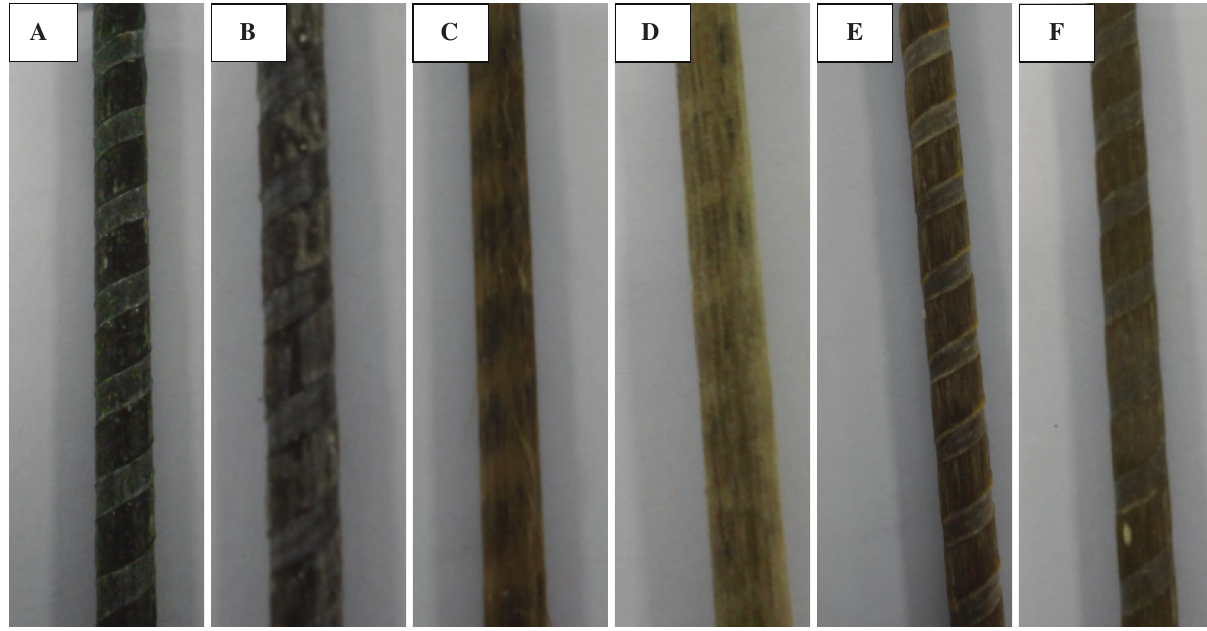
Figure 11: Appearance of basalt fiber-reinforced polymer (BFRP) bars: (A) BDSM-WD bars; (B) BDSM-CI bars; (C) BE-WD bars; (D) BE-CI bars; (E) BMFE-WD bars; (F) BMFE-CI bars. CI, continuous immersion; WD,